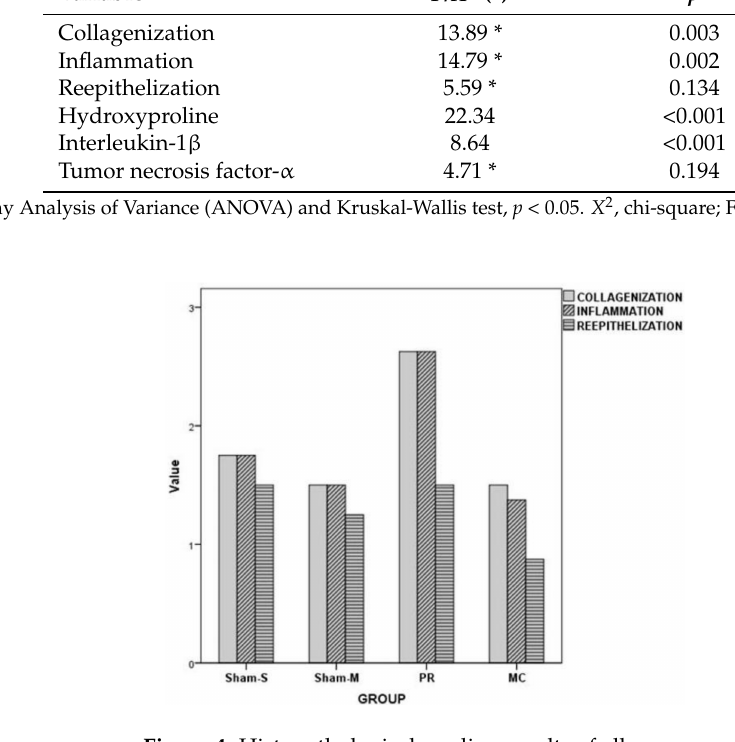
Figure 4. Histopathological grading results of all